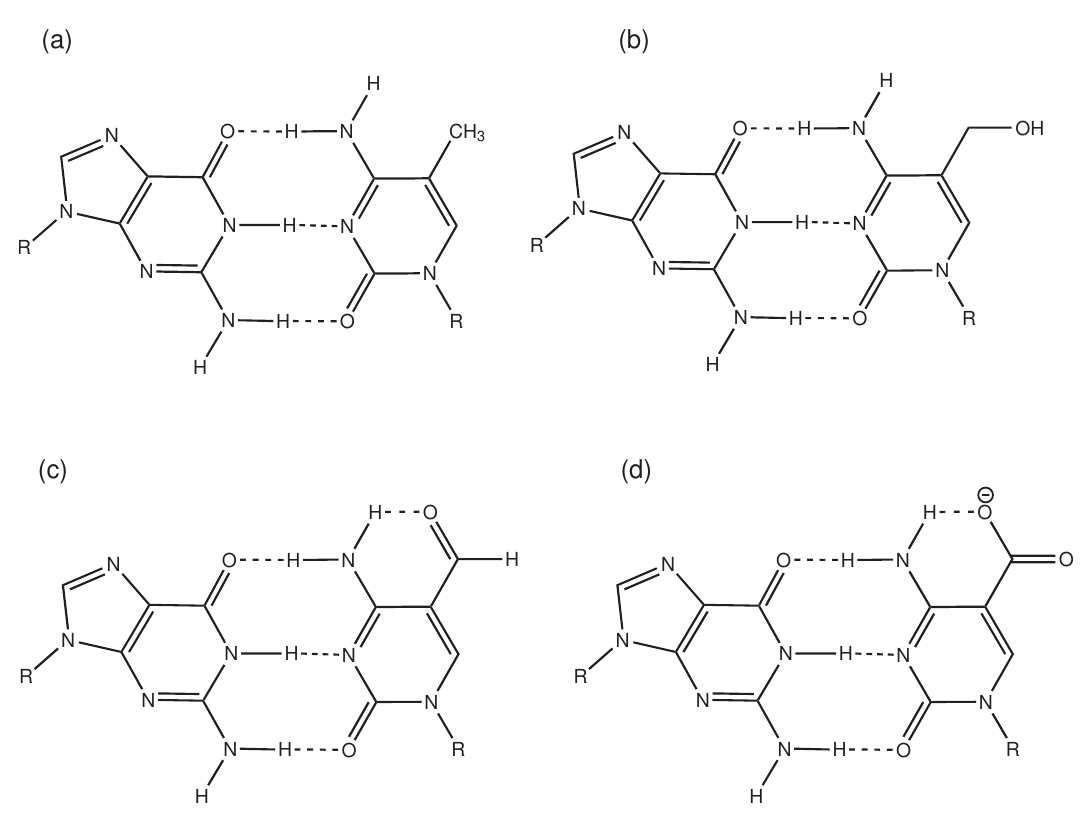
Figure 7. Schematic drawing of ( a ) 5-methyl-cytosine; ( b )